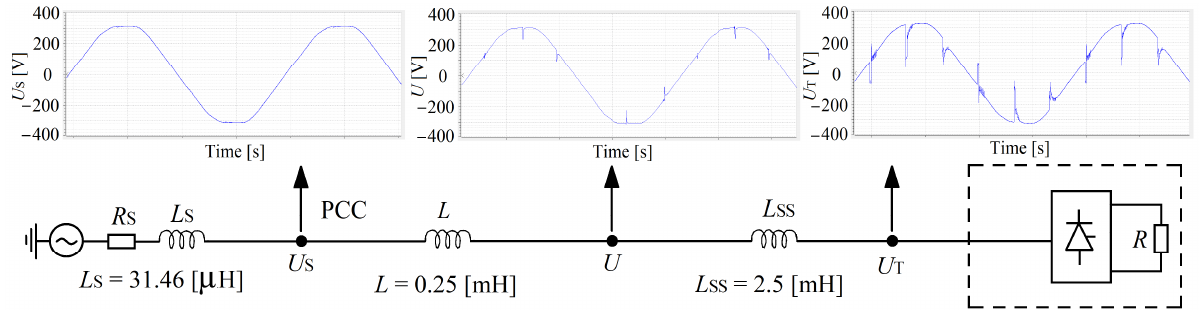
and after the line reactor connection.